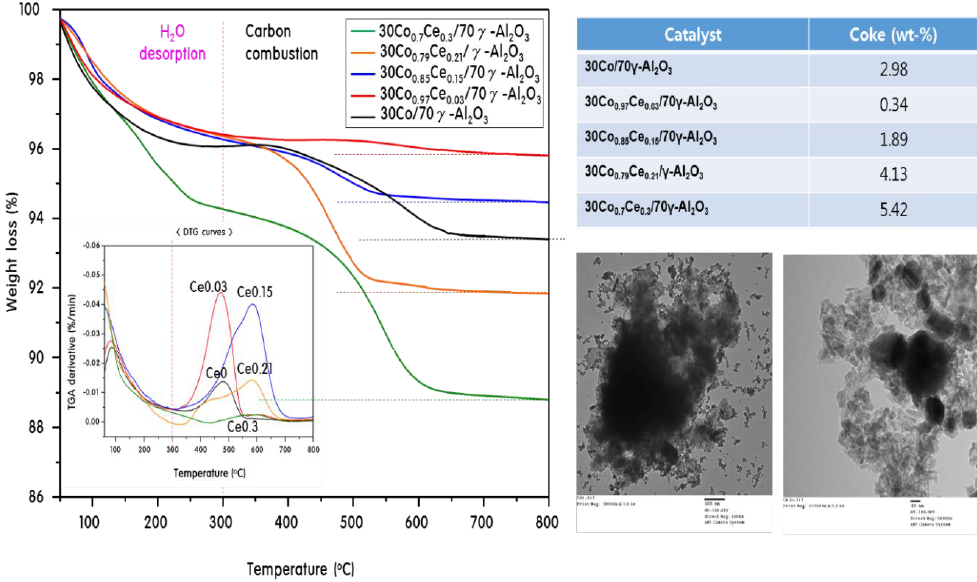
Figure 9. TGA and TPO curves for coke combustion and TEM images of the used 30Co x Ce y /70γ-Al 2 O 3 catalysts after PSR. catalysts after